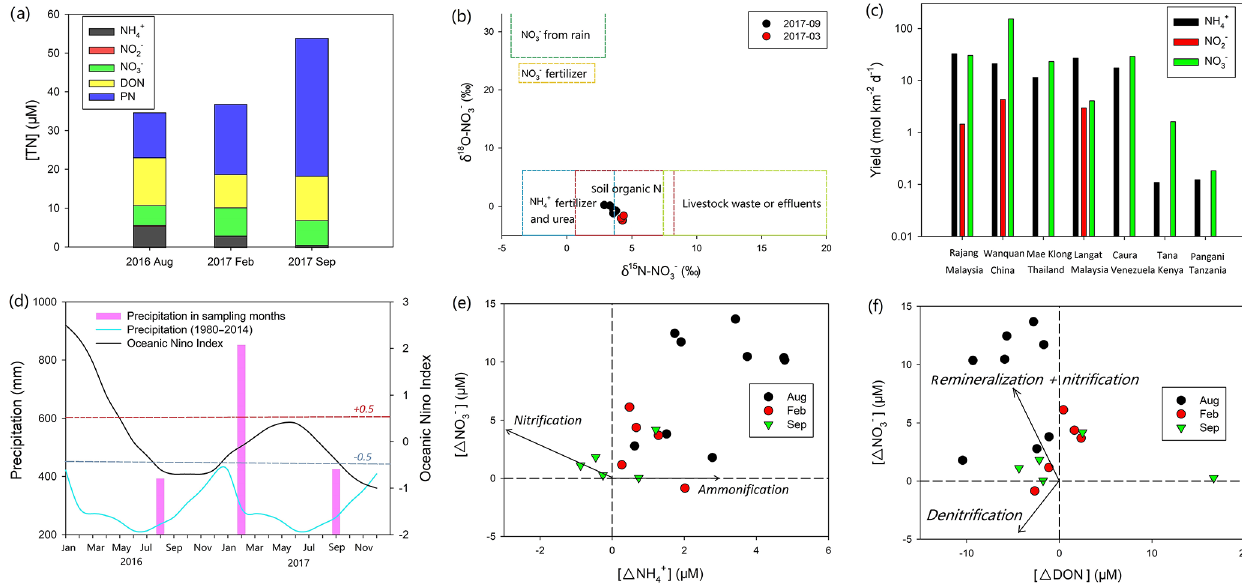
Figure 7. (a) Mean concentration of different N species in the fresh Rajang water (salinity: 0, sampling sites ranged from the upper stream to Sibu); (b) δ 15 N–NO − to δ 18 O–NO − in the fresh Rajang water. The figure also highlights the range of both isotope fractions in rainwater, 3 3 fertilizer, terrestrial organic matter and sewage (Li et al., 2010); (c) comparison of DIN yield among different tropical rivers on a global scale; (d) annual precipitation curve derived from Müller et al. (2016) in Sarawak and precipitation in the sampling months during 2016 and 2017, measured at Sibu station. The figure also shows the Ocean Niño Index in 2016 and 2017. Clearly, in the beginning of 2016, an El Niño event occurred because the index was much higher than the threshold (red dash line: 0.5). Afterwards, two La Niña events were observed (lower than the threshold, highlighted by the blue dash line); (e) and (f) are comparisons among offsets ( (cid:49) in the figure) for NO − concentrations in the Lassa branch. The arrows outlined in the figure highlight the possible reaction pathways according to the variations in the